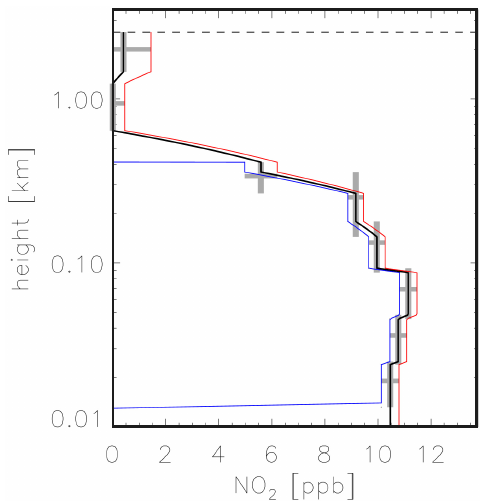
Fig. 13. Example of lidar NO 2 profile measured at the CINDI campaign. In gray the individual lidar measurements are shown, where the vertical bar shows the range to which the concentration applies, and the horizontal bar shows the uncertainty range of the average concentration. Note that the vertical ranges sometimes do and sometimes do not overlap. The black line shows the continuous profile derived from the discrete measurements (according to a pro- cedure explained in Sect. 5.2.1) that is used to determine the inte- grated partial NO 2 column. The blue and red profiles are used to de- fine the uncertainty range of the partial NO 2 column: the blue pro- file is based on conservative estimates, the red on non-conservative estimates. The horizontal dashed black line indicates the height above which no measurements were